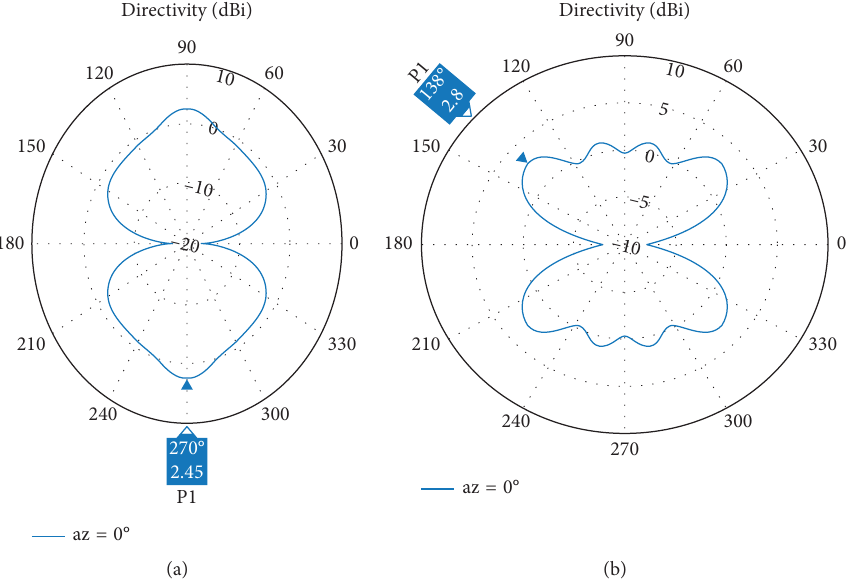
Figure 5: One-iteration fractal Koch antenna 360 degrees directivity (more precisely, one-iteration Koch’s curve at 460MHz left and right at